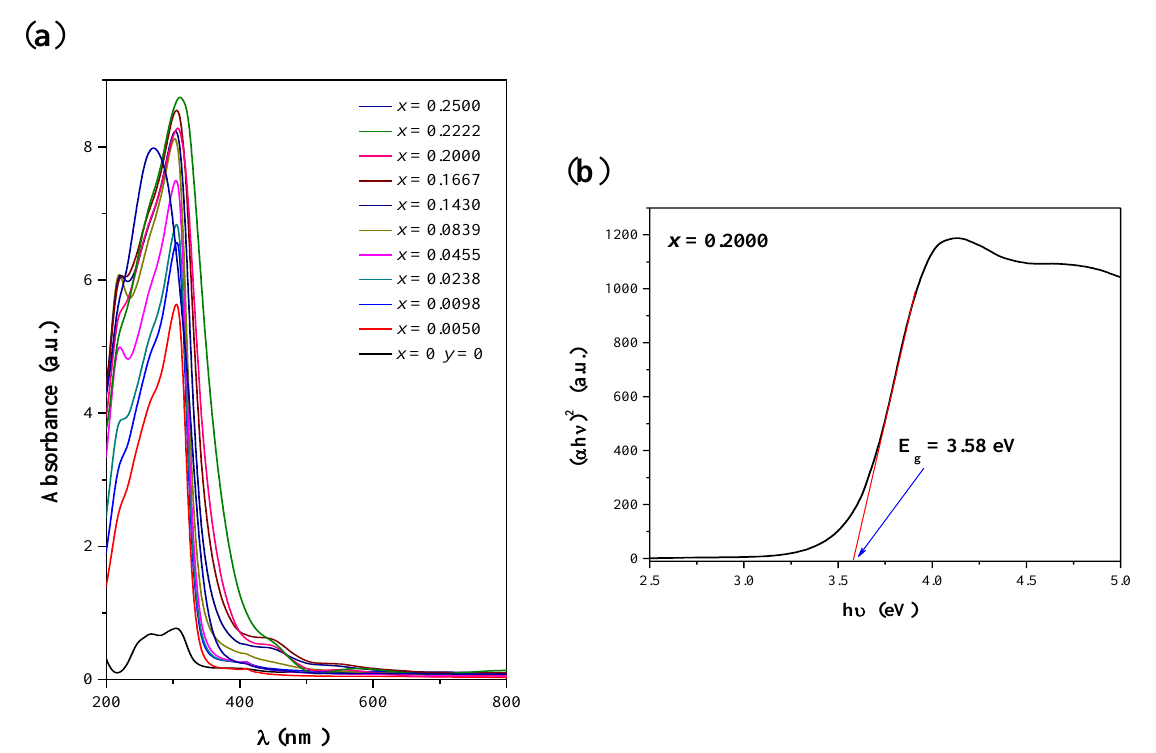
Figure 7. UV-vis absorption spectra of CaMoO 4 and CaMnGdMoWO ceramic materials obtained by solid state reaction method when 0 < x ≤ 0.2500 and y = 0.0200 ( a ); Plot of ( α h ν ) 2 vs. photon energy (hν) of the solid solution sample when x = 0.2000 and y = 0.0200 with determined band gap energy (E g ) ( b ).